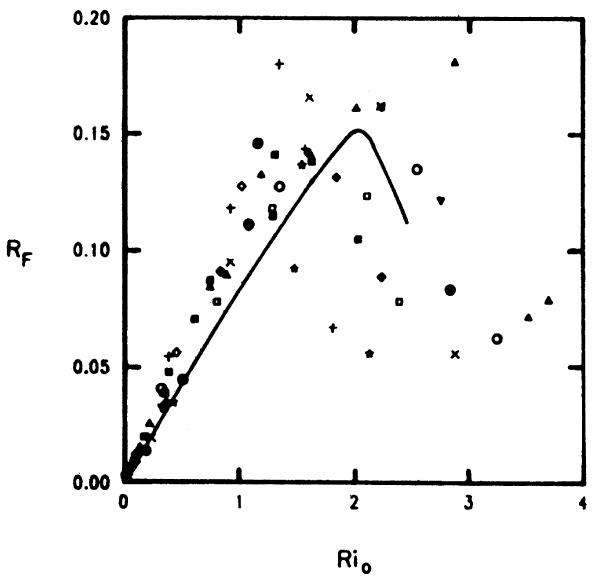
Fig. 4. The flux Richardson Number, R f , versus the turbulent Richardson number, Ri o = N 2 L 2 m /q 2 (observations and model), from Rohr et al. (1984) and Weinstock (1992).